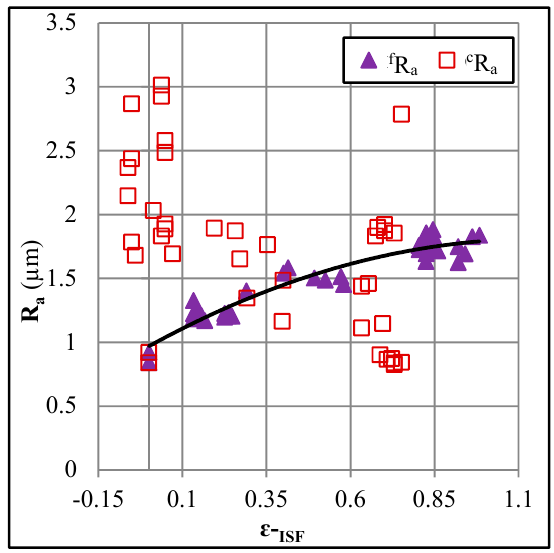
Figure 4. Correlation between the mean roughness and ISF strain.